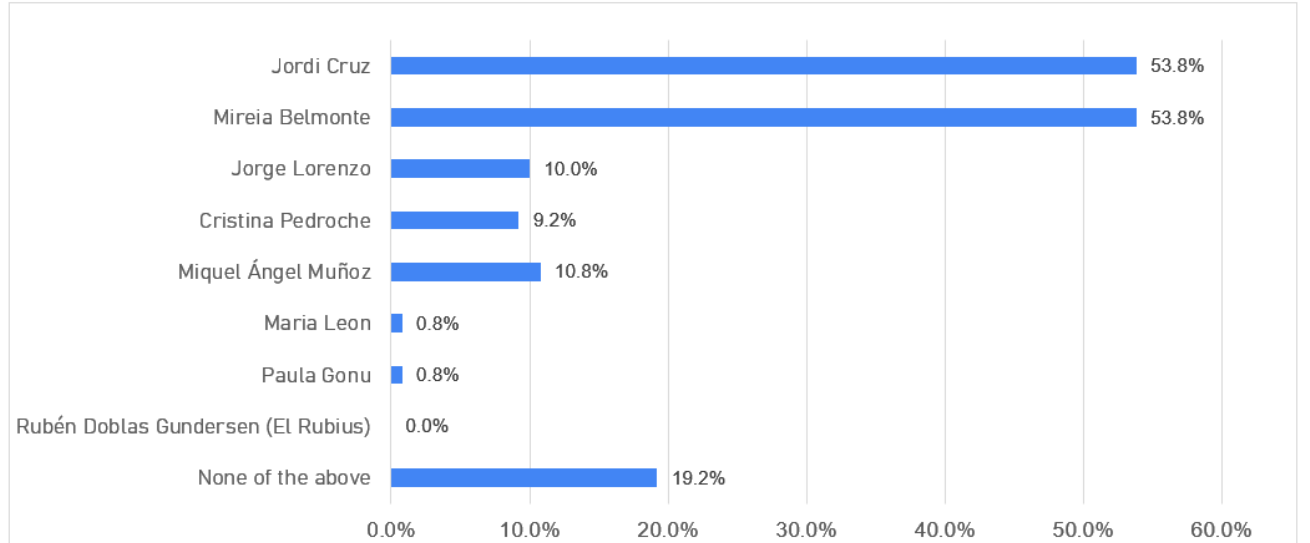
Figure 6. Best opinion leaders for healthy snack promotion.